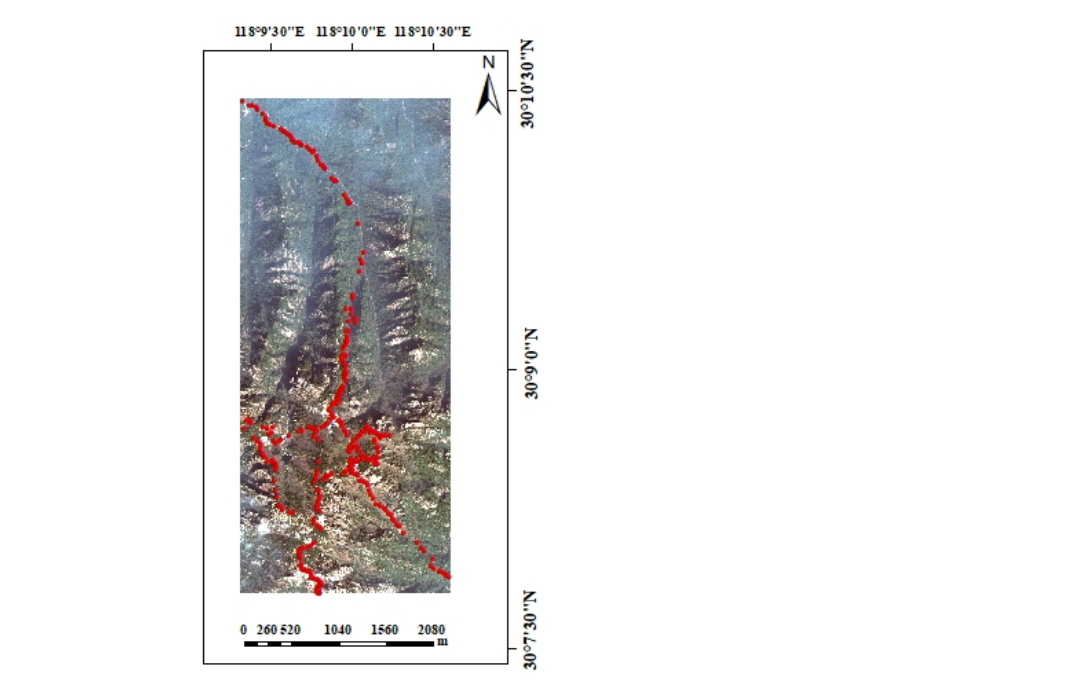
Figure 2. WorldView-3 study area imagery. Figure 2. WorldView ‐ 3 study area imagery. Figure 2. WorldView ‐ 3 study area imagery.